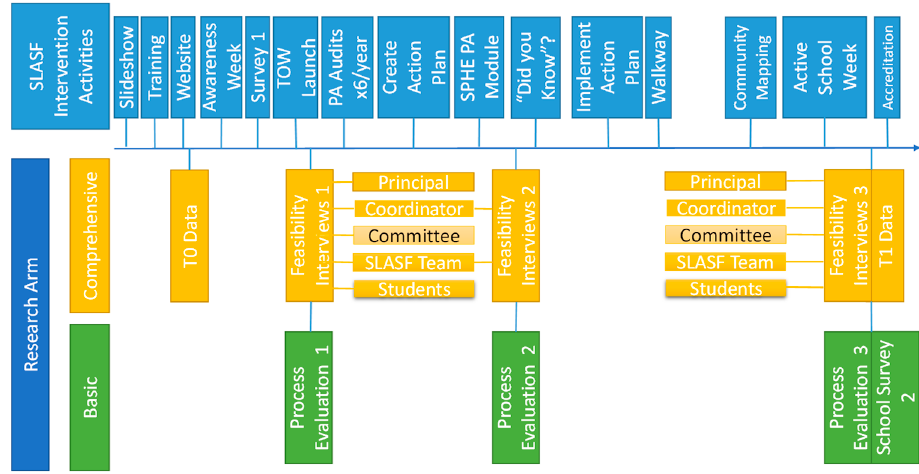
Figure 1. Second Level Active School Flag (SLASF) Intervention and Research Components Timeline.